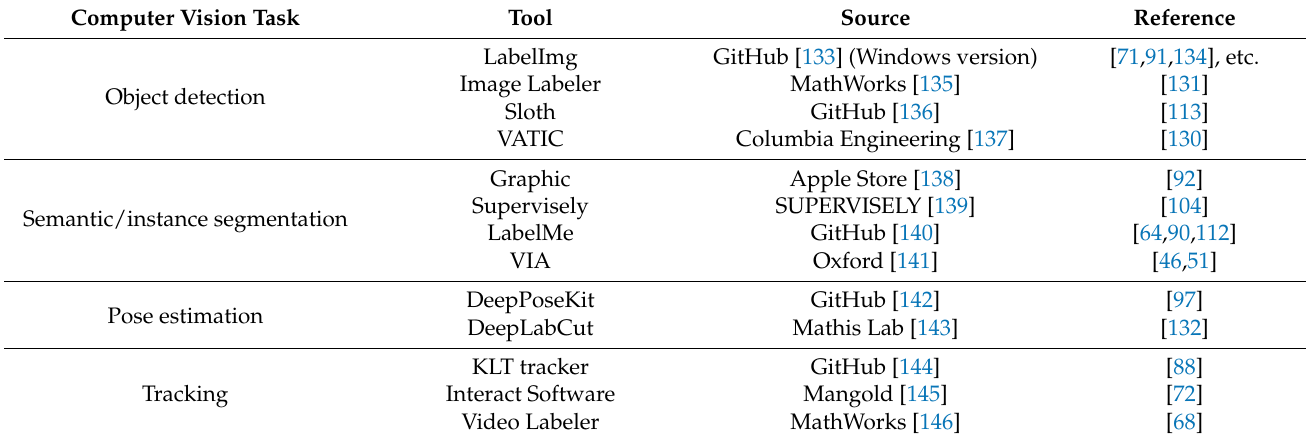
Table 2. Available labeling tools for different computer vision